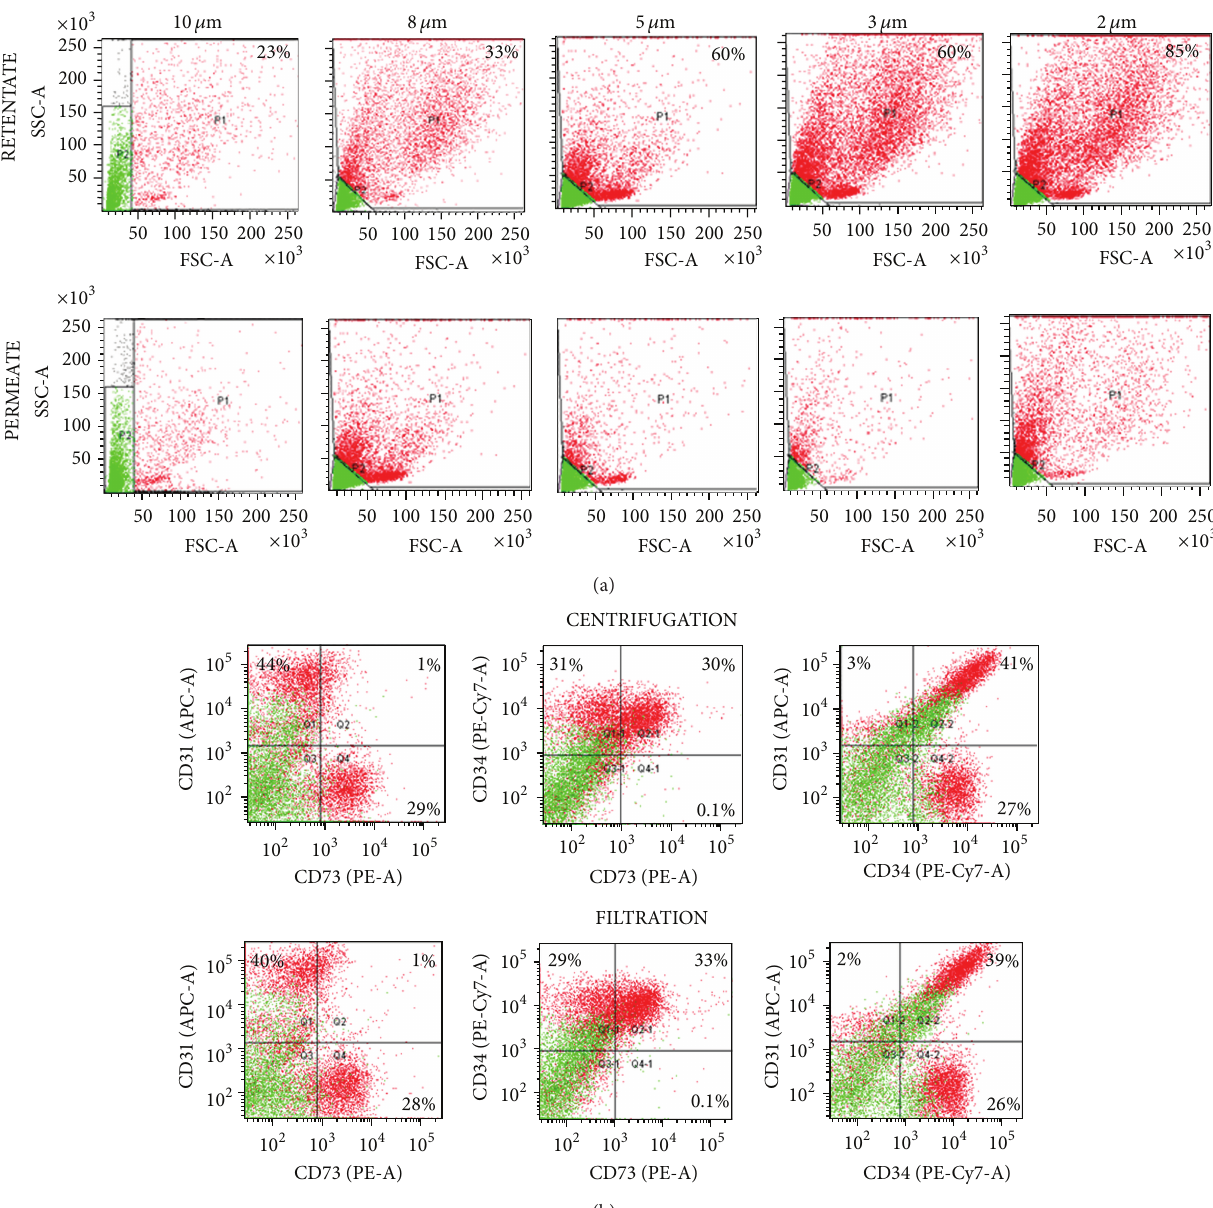
Figure 2: SVF recovery by filtration. (a) The figure shows a representative flow cytometry light scatter profile for SVF cells that have been recovered from the retentate and permeate fractions of filters of indicated pore size in 𝜇 m. Percentage values represent the proportion of cells retained on the filter membrane relative to the total cell number in the whole SVF before filtration. Data shows a representative set of light scatter plots from four individual donors in each group. Events in gates P1 (red) and P2 (green) represent the FSC hi and FSC lo populations, respectively.(b)AntibodylabellingandflowcytometricdetectionofcellsurfacemarkersexpressedbySVFcellsrecoveredbycentrifugationor filtration using 5 𝜇 m PCTE filter. The percentage positive cells for each marker combination is calculated after subtraction of the nonspecific fluorescence obtained with the isotype controls. Data shows a representative set of plots from four individual donors in each group. Plots represent events from both FSC hi (red) and FSC lo (green)